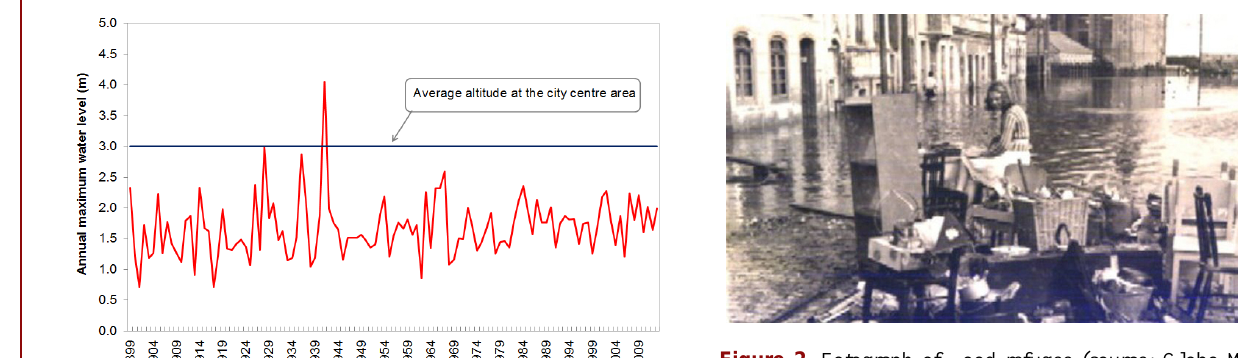
Figure 2. Fotograph of flood refugee (source: Globo Magazine, 1941).